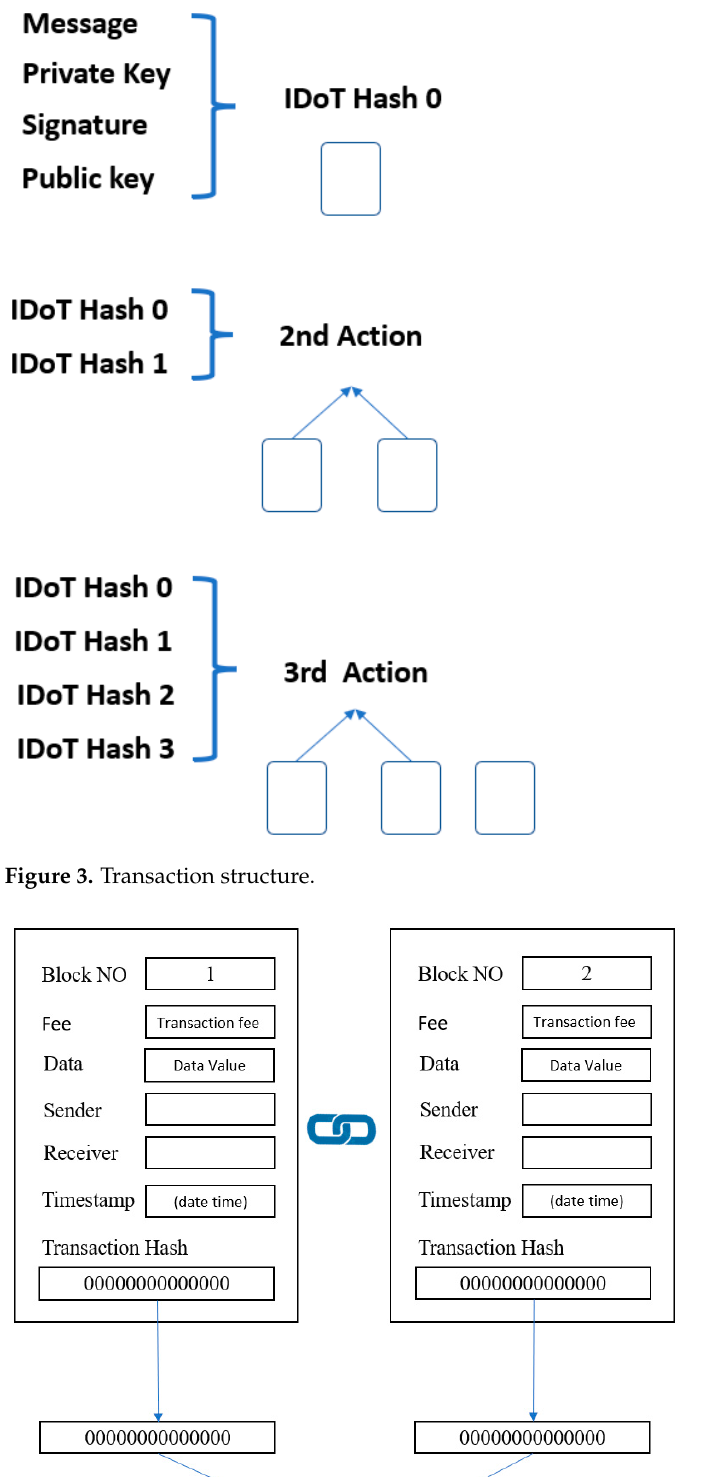
Figure 3. Each block connects to the next block and block data structure and is shown in Figure 4.